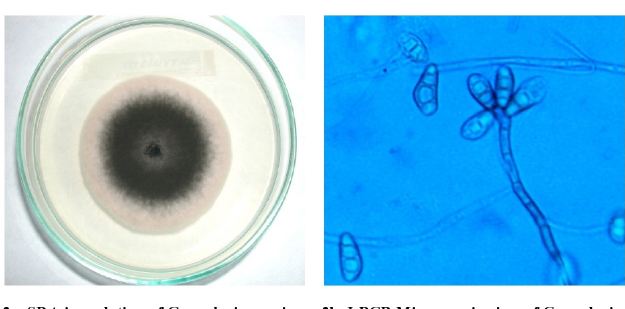
Fig. 2. Phenotypic and Microsopic identification of Curvularia species by Lacto-Phenol Cottone